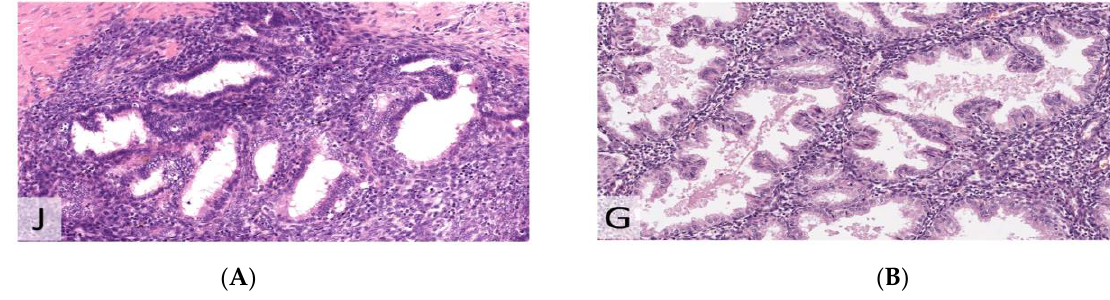
Figure 7. Hematoxylin and eosin (H&E) staining (×200). ( A ) Endometriosis. ( B ) Endometrium.